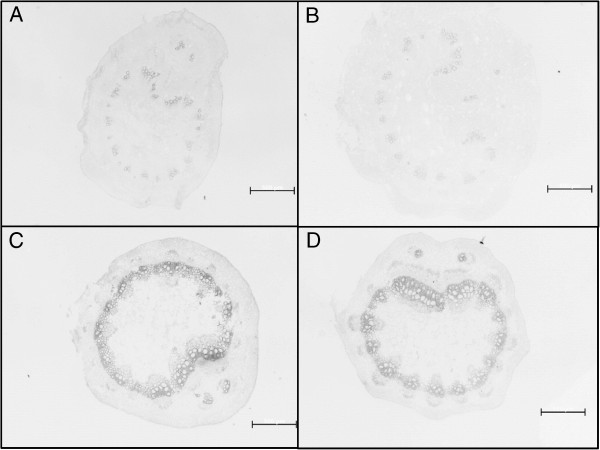
Suberin accumulation in response to water deficit. Cross section of petioles dyed with aniline blue for suberin (in dark grey) estimation for Cabernet Sauvignon (Cs) irrigated (A), Shiraz irrigated (B), Cabernet Sauvignon water deficit (C) and Shiraz water deficit (D) treatments on day 34 of the experiment. Bars = 500 μm (n = 6). Fluorescence reflectance (i.e., suberin accumulation) of the tissue from D plants (C,D) increased in Shiraz (3.21 fold) and in Cs (2.01 fold) compared to in the tissue from IR plants (A,B).